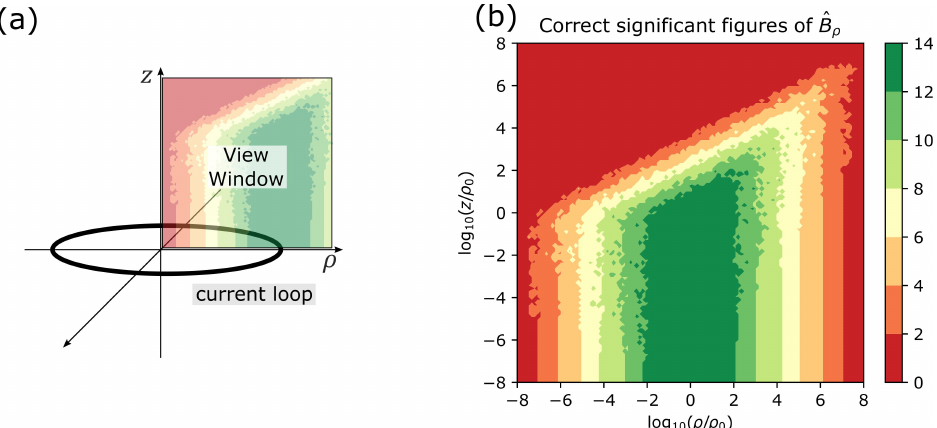
Figure 1. ( a ) Sketch of a current loop and the observed first quadrant. ( b ) The number of correct significant figures of a straightforward implementation of the textbook expression for the radial component of the B -field of a current loop on a log–log